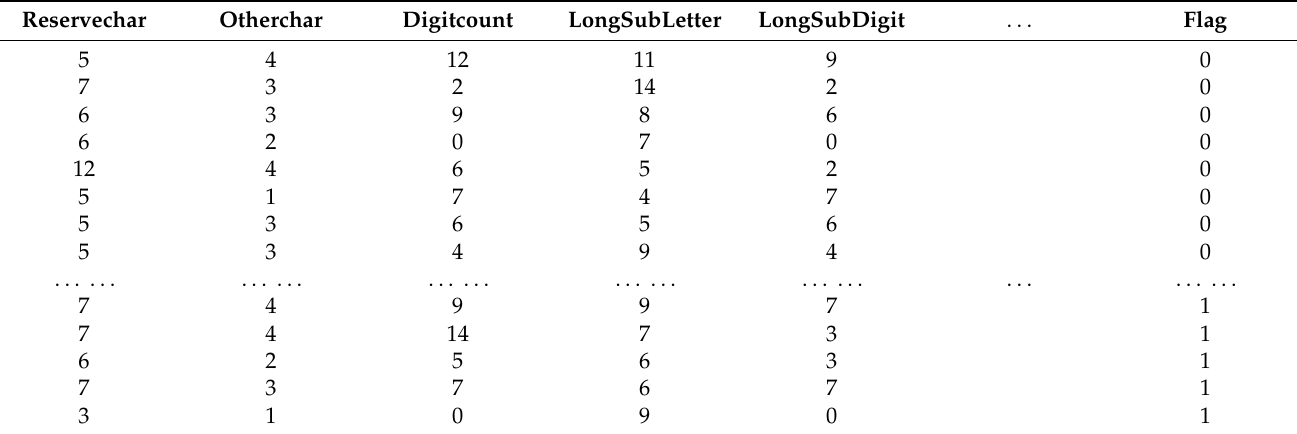
Table 3. The data set after feature